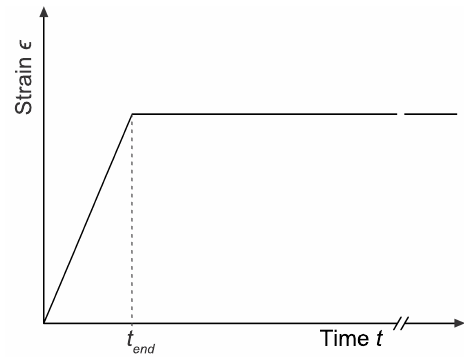
Figure A1. Strain applied during the stress relaxation